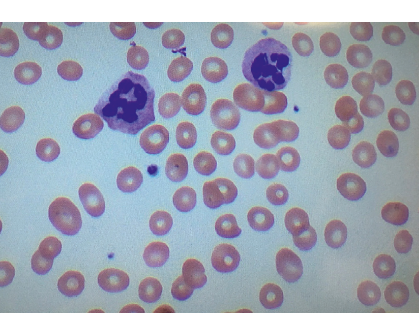
Figure 1: Hypersegmented neutrophils and hypochromic eryth- rocytes characteristic of a megaloblastic anemia. H&E stain. Magnification: